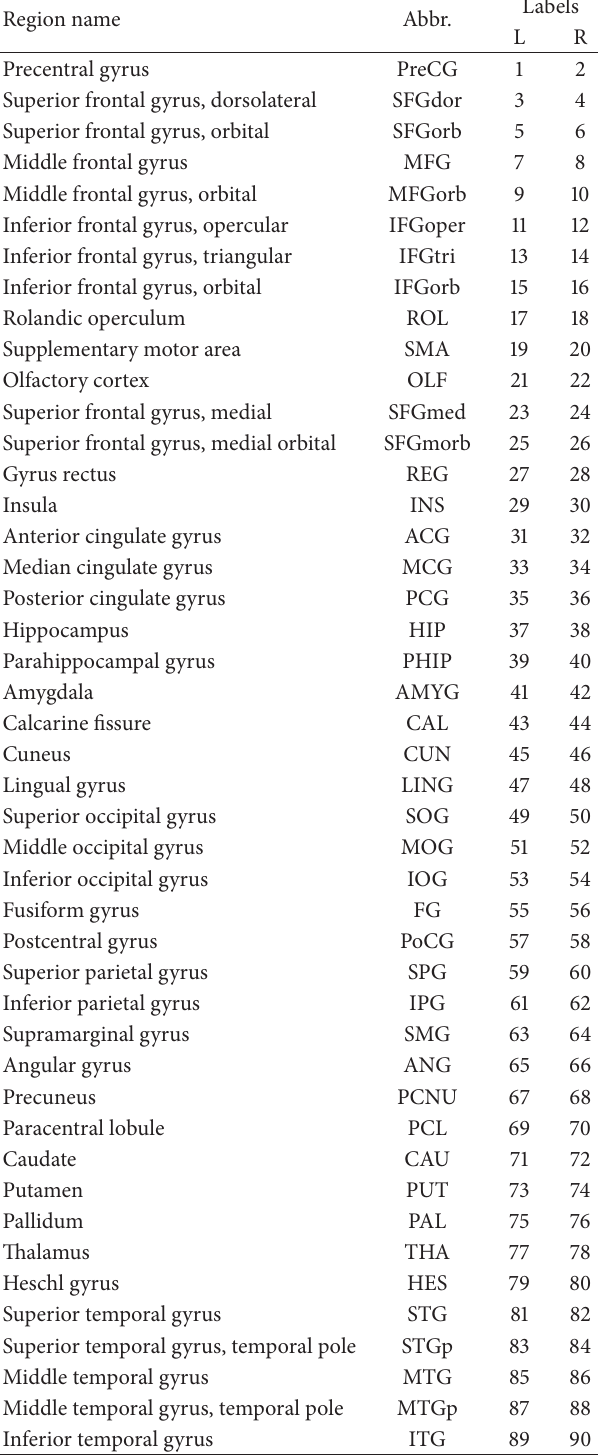
Table 2: Regions of interest (ROI) defined in AAL